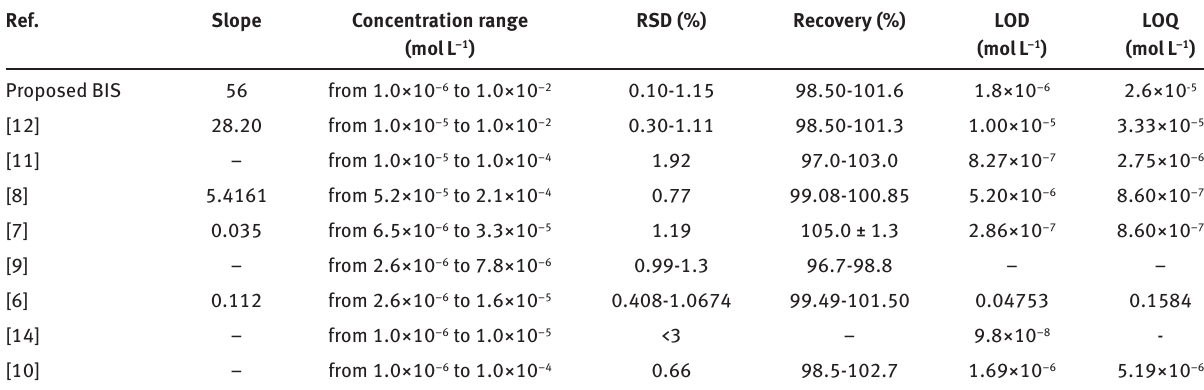
Table 8: Comparison between the proposed sensor and previous methods for BIS